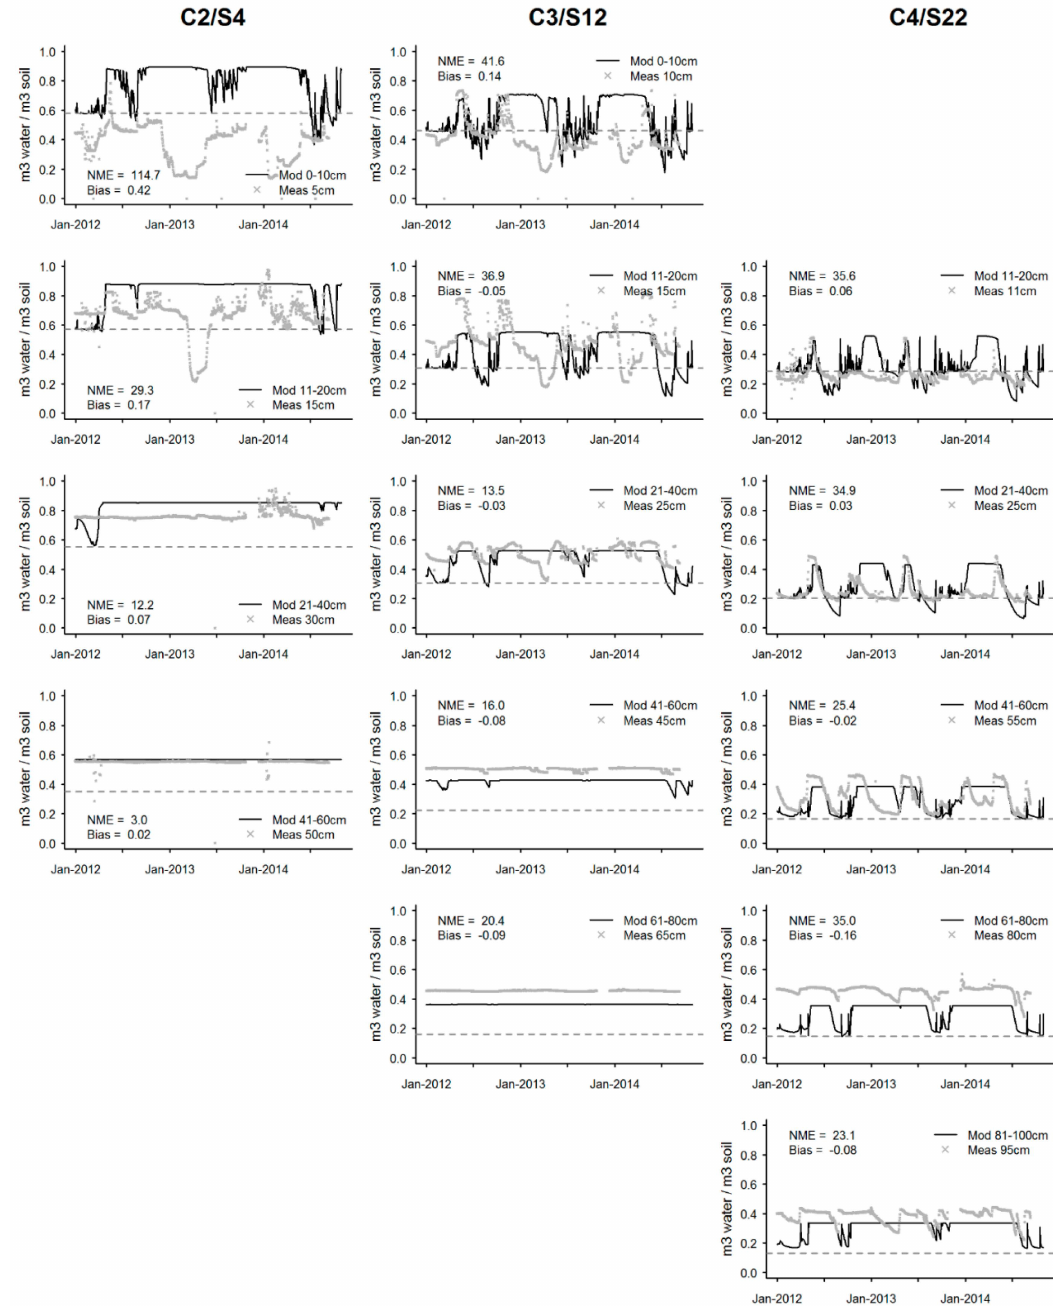
Figure 8. Modelled soil moisture as compared to the TDR data at increasing distance from the stream. The three modelled soil columns up to 25 m from the stream (C2, C3, C4) are compared to the measurements at the sampling points at 4, 12 and 22 m (S4, S12, S22). For each soil profile, simulations and measurements are compared at different soil depths. Modelled layers of similar depths are compared in the same row. Measurements were not available for layers that are missing. Differences between model and measurements are evaluated in terms of NME (%) and Bias (m 3 ¨ m ´ 3 ). Dashed grey lines represent the water content at field